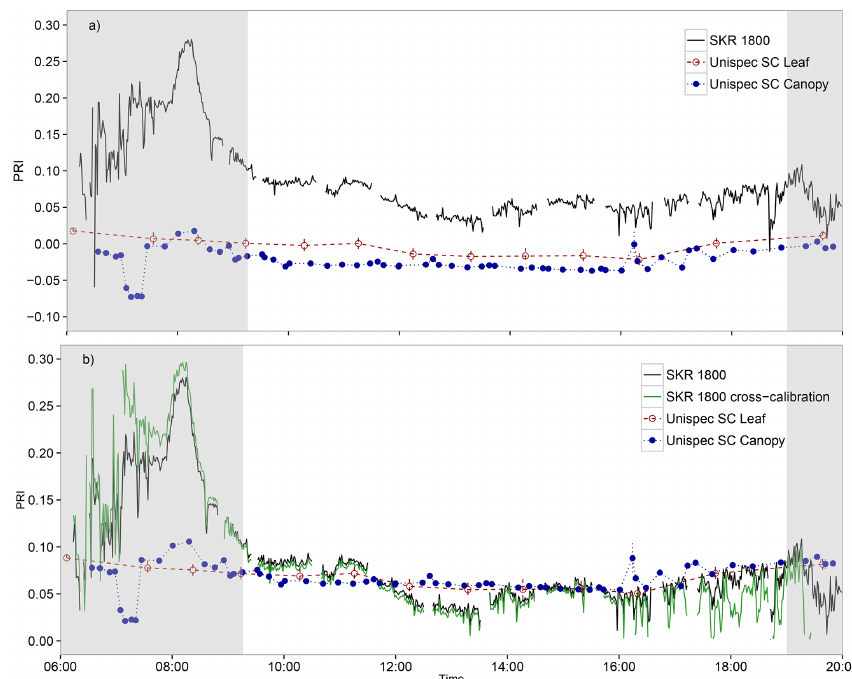
Figure 7. Lodgepole pine ( Pinus contorta ) canopy and leaf photochemical reflectance index (PRI) as a function of time of day. Mean values for each sampling period are shown for both UniSpec instruments and the error bars represent ± 1 standard error (SE). Panel (a) shows the original data values and the shaded areas indicate times of day where the solar zenith angle (SZA) exceeds 60 ◦ . Panel (b) shows data that have been corrected to normalize the SRF differences between instruments and the shaded areas indicate times of day beyond those used for generating the SKR 1800 cross-calibration functions using white